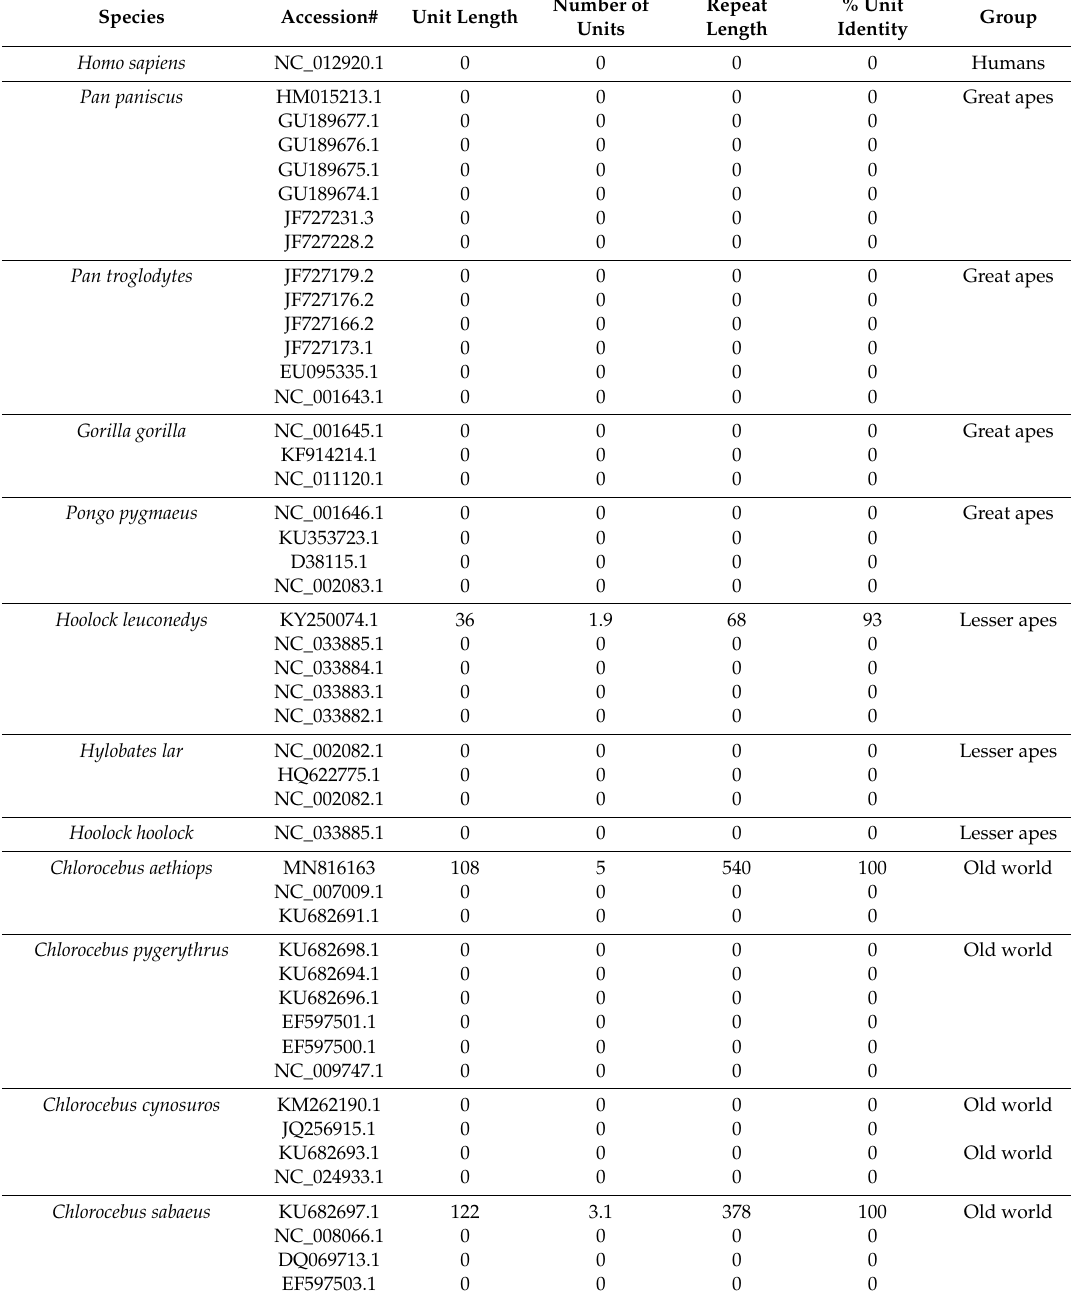
Table 1. Prevalence of the tandem repeats in control regions of the select primate mitochondrial genomes